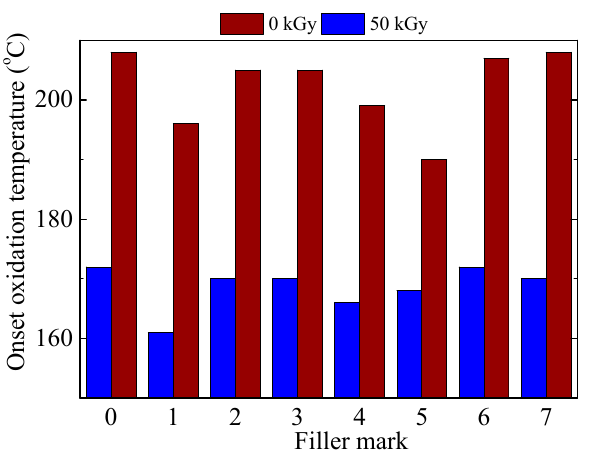
Figure 4. OOT values for the start of oxidation in PP/modified-POSS hybrids.